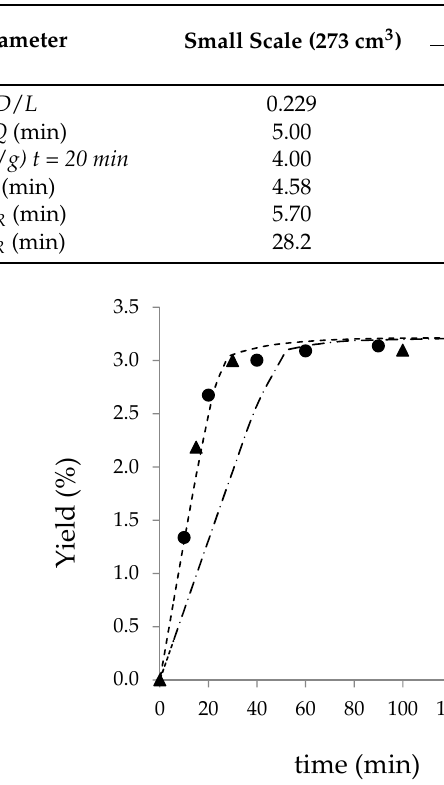
Figure 2. Scaling-up of Mortiño SFE at 40 °C and 30 MPa. Full symbols represent experimental data: ( ● ) small-scale cell with Q SS = 32 g·min − 1 ; ( ) large-scale cell with Q LS = 158.0 g·min − 1 (Equation (2)). Lines represent the different BIC model periods: (- · - ·) Q LS = 77.6 g·min − 1 and (- - -) Q LS = 158.2 g·min − 1 .